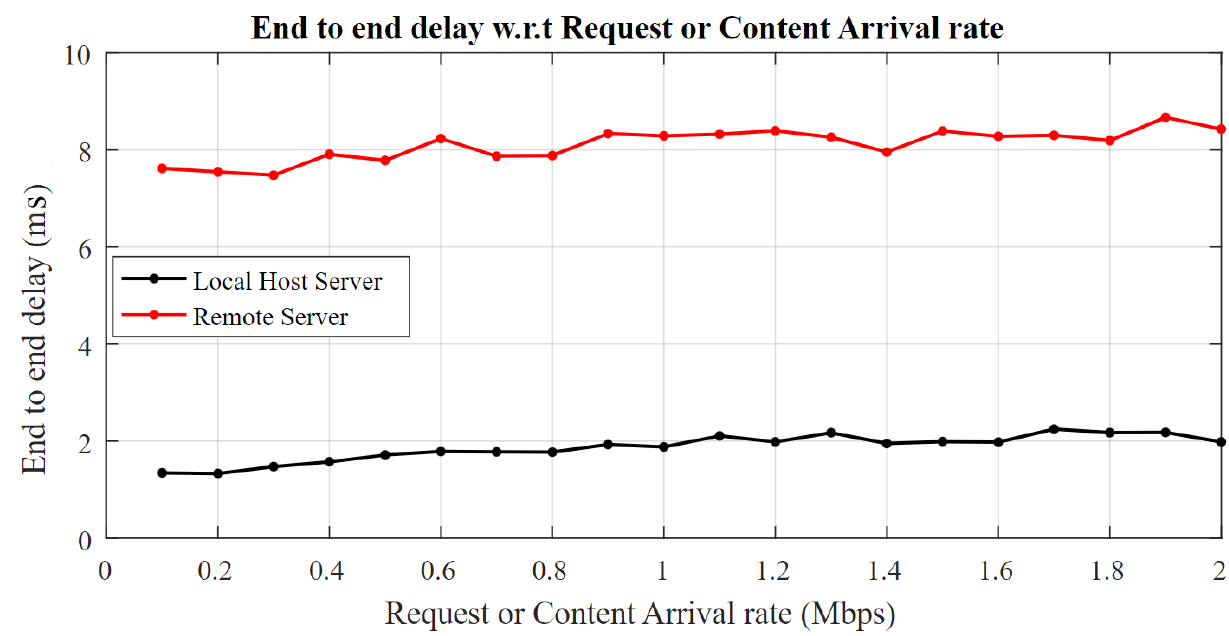
Figure 5. End-to-end delay for request and content arrival.